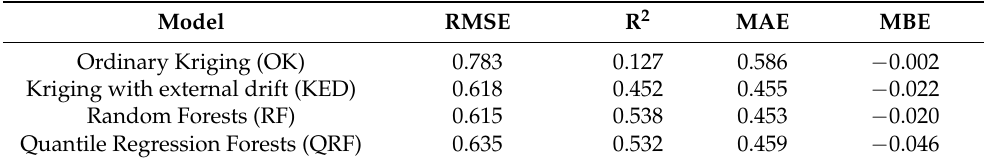
Table 6. Prediction results for soil OM.